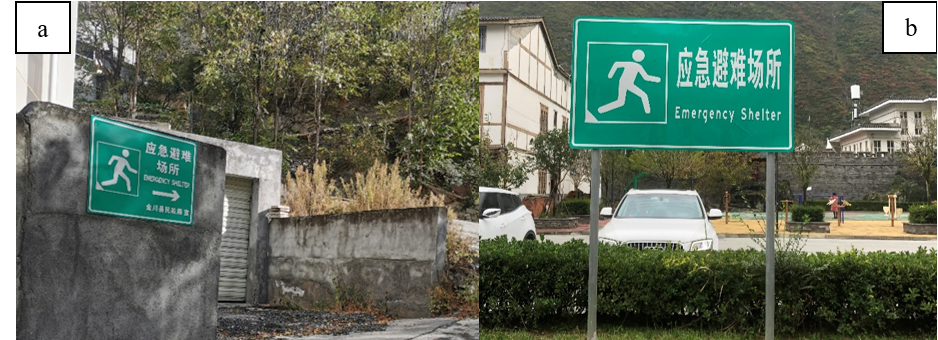
Figure 5. Emergency shelter signage: (a) emergency evacuation route sign, (b) emergency shelter